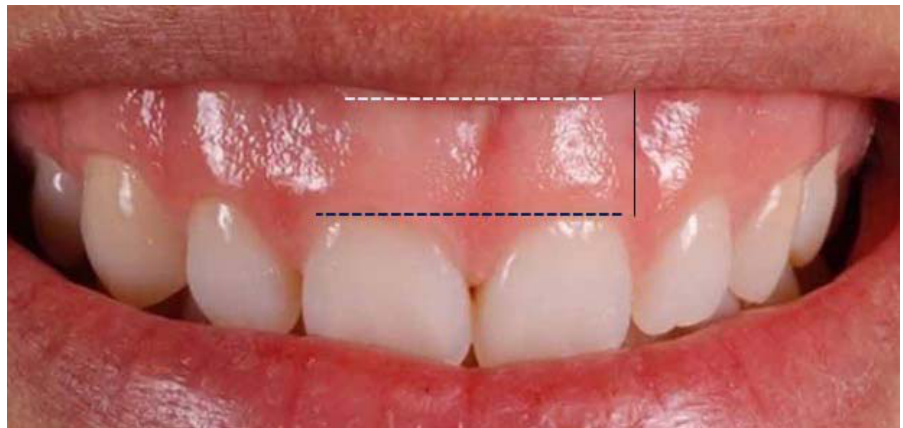
Figure 1. Gingival maxillary exposure during full smile evaluation.